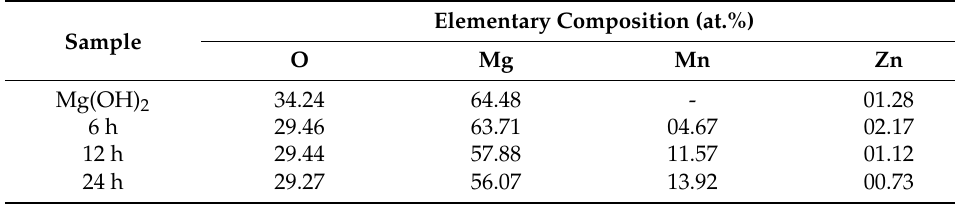
Table 1. EDS results on different samples.